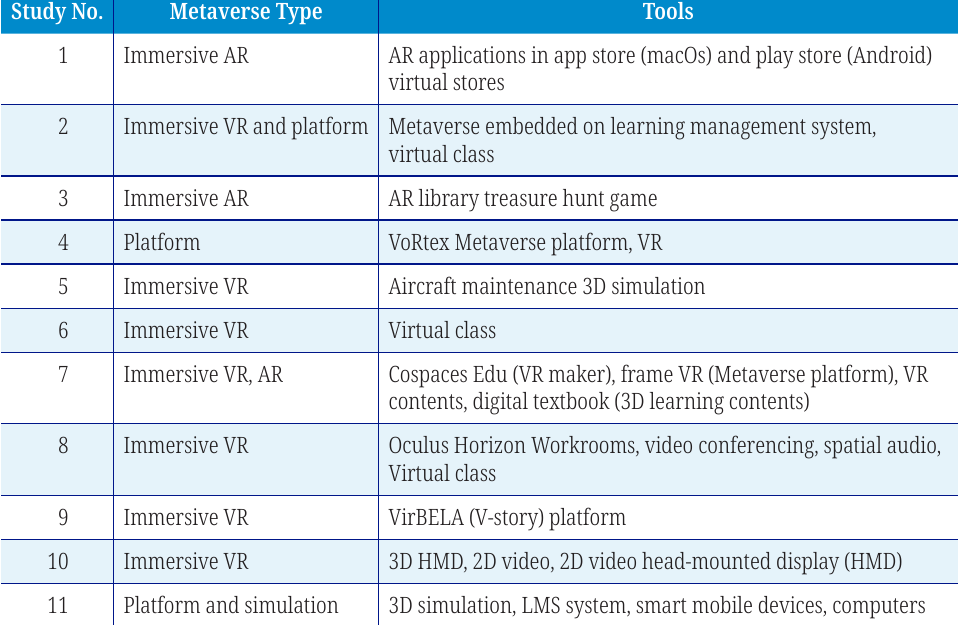
Fig. 3. Metaverse technologies and tools used in studies Table 3. Metaverse types and tools used in selected